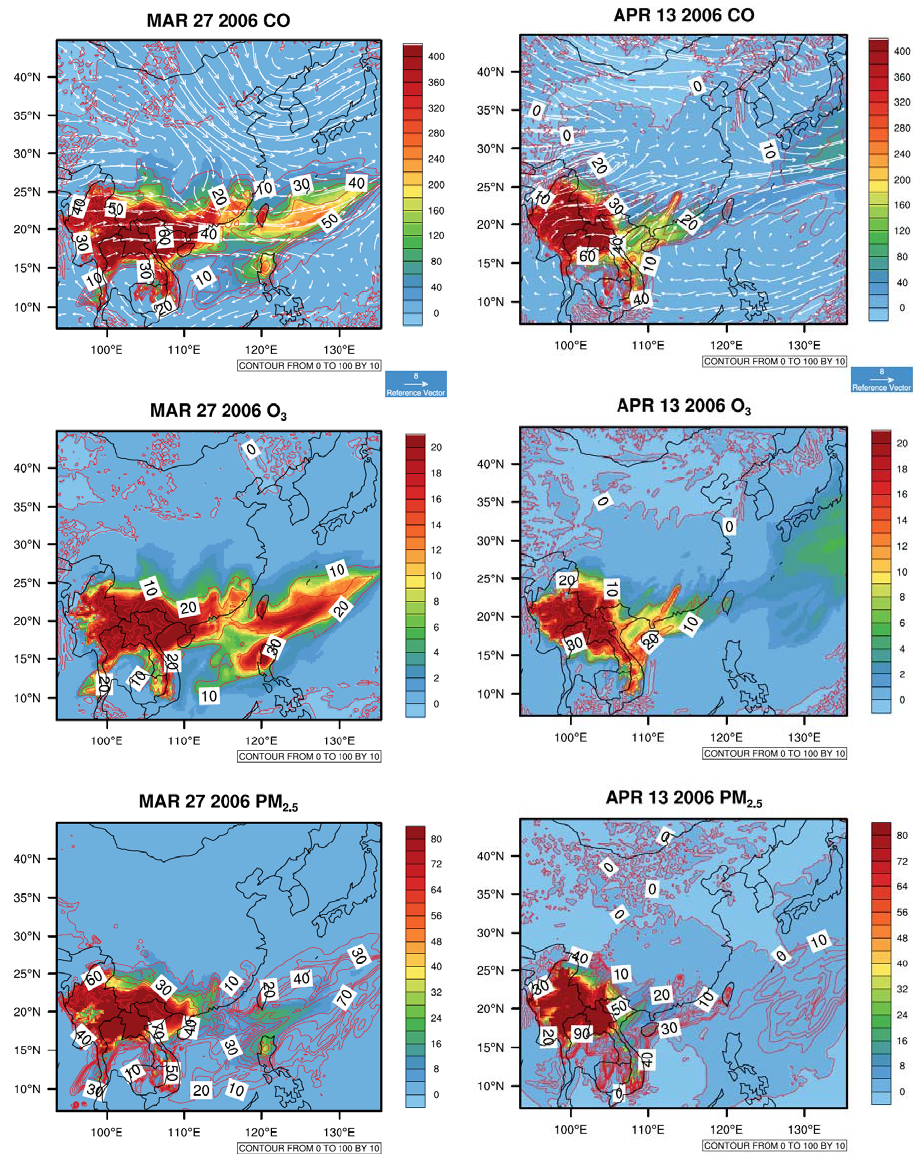
Fig. 6. Impact of biomass burning in Southeast Asia on 27 March and 13 April 2006. Color contour represents the concentrations for each species: the top panel shows CO (unit: ppbv) concentration, the middle panel shows O 3 concentrations (unit: ppbv) and the bottom panel show PM 2 . 5 concentrations (unit: µgm − 3 ) . The red contour lines represent percentage contribution from biomass burning. The white arrows denote the wind vectors in the 15th vertical layers at the altitude of 2.4km.